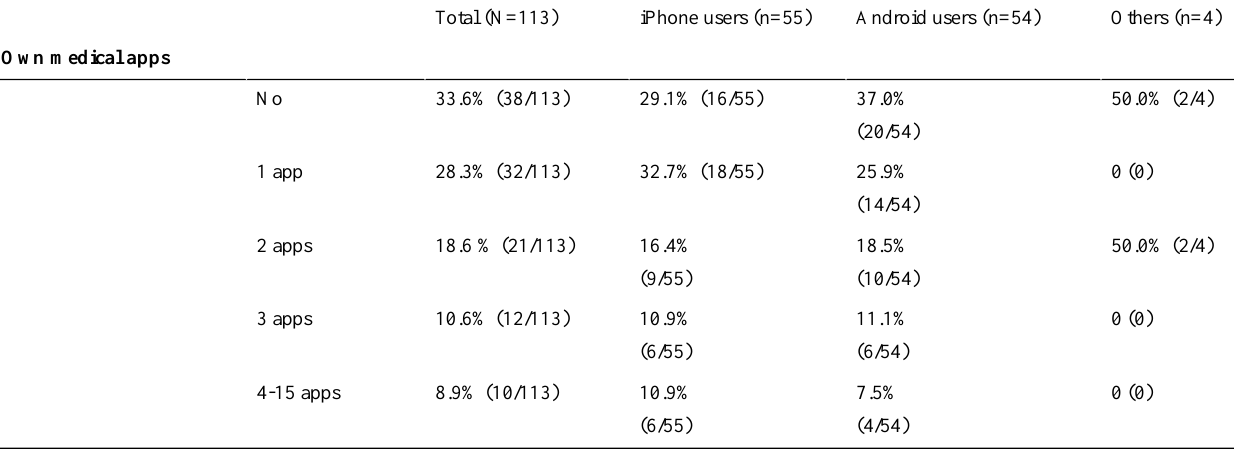
Table 1. Number of medical apps installed by GPs.